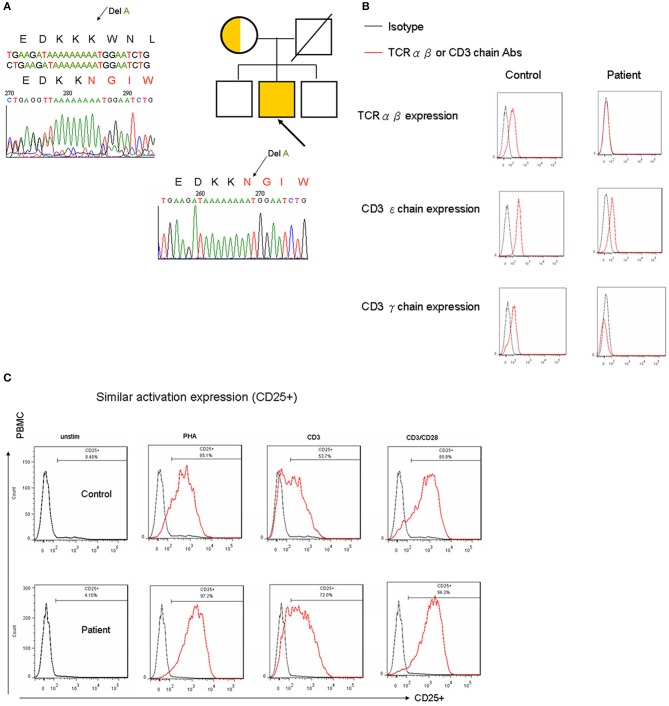
(A) Whole-exome Sanger sequencing mutually identified an A deletion that caused N to be substituted by K at the 71st amino acid; this interrupted the last two amino acids of the immunoreceptor signaling ITAM domain and truncated at the following 39 location in the CD3G gene. (B) Following CD4+ gating for surface CD3-TCR complex expression, CD3ε chain expression decreased by one-log fluorescence intensity, and the γ chain of the CD3 complex was almost undetectable. There was an obvious decrease in TCRαβ in the patient with a CD3γDel
213A mutation. Similar results were obtained following CD8 gating (data not shown). The units of the y-axis are cell counts between 0 and 200. (C) 5 × 105 PBMCs per well were cultured with 5 mg/mL phytohemagglutinin (PHA) or 100 ng/mL anti-CD3, either alone or in combination with 100 ng/mL anti-CD28, for 4 days. The lymphocyte proliferation staining with the activation marker for CD25 in flow cytometry was similar between the patient and the healthy control.